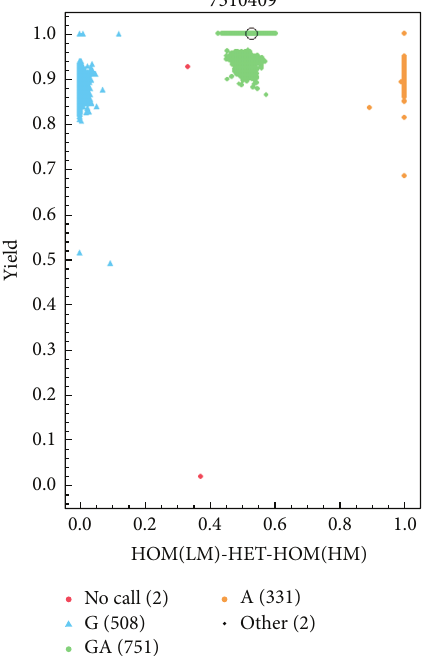
Figure 2: Genotyping of HNF1A rs7310409 G/A by MALDI-TOF mass